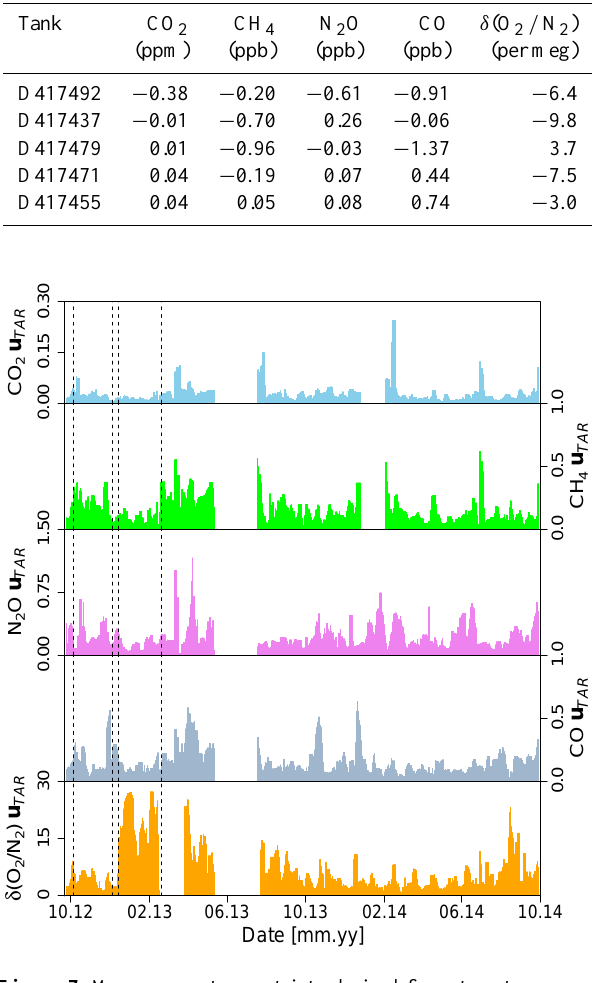
Figure 7. Measurement uncertainty derived from target measure- ments ( u TAR ). Mean bias (i.e., differences from MPI-BGC deter- minations of target tank mole fraction from NDAO’s determination) for each tank has been removed to better approximate the sample uncertainty (see Table 4). Dashed vertical lines indicate a target tank